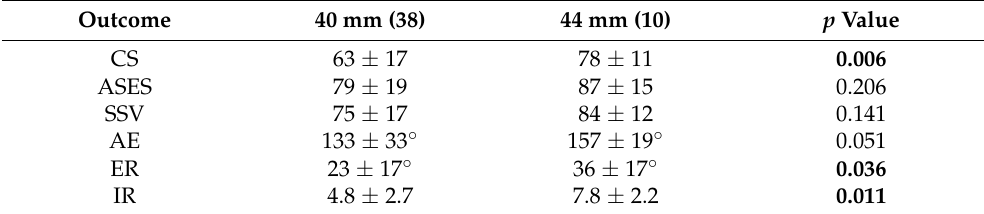
Table 2. Clinical outcomes according to glenosphere size. No preoperative or demographical differences were found between the two groups.